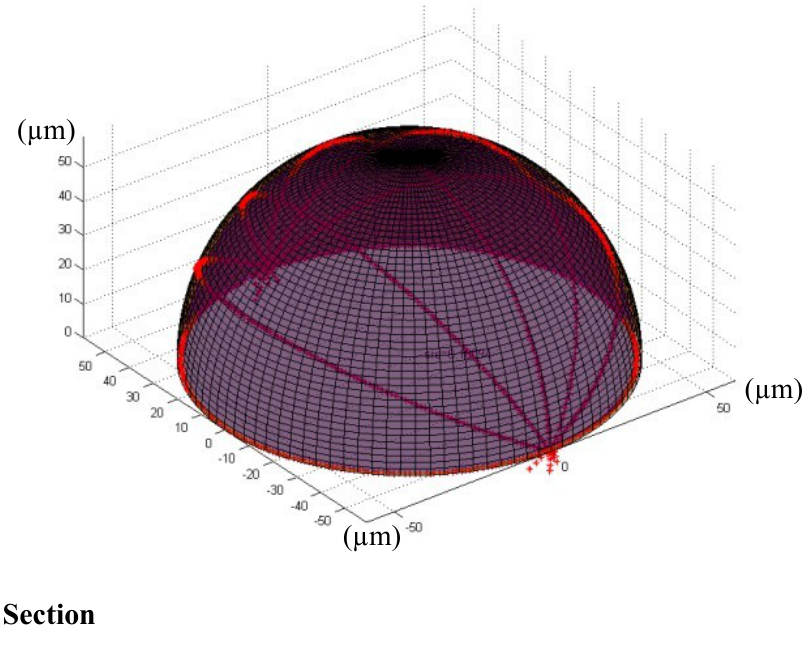
Figure 7. 3D fitting surface profile of the optical fiber